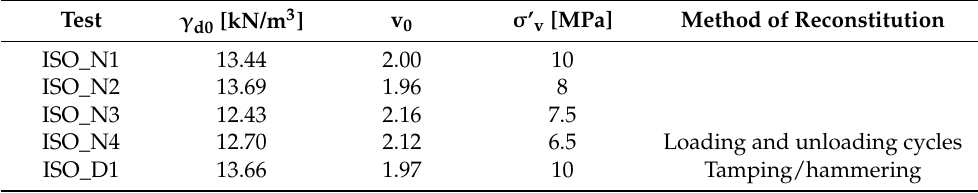
Table 2. Details of the isotropic compression tests (ISO-N Natural, ISO-D Destructured).